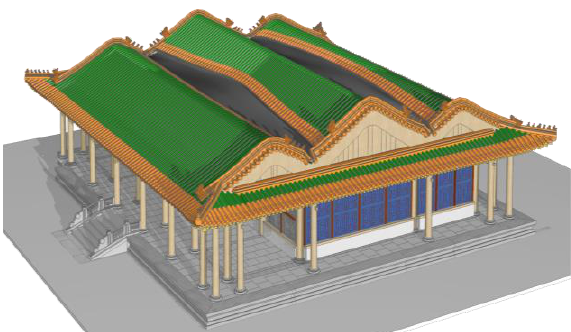
Figure 13. BIM model for the Main Hall of Jingfu Palace, Forbidden City (the Place Museum), Beijing